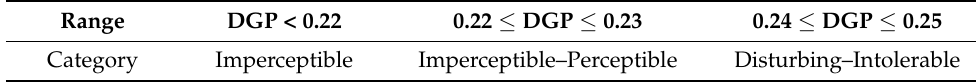
Table 3. DGP criteria employed in this study, adopted from [46].